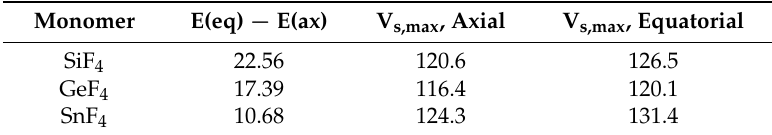
Table 3. Difference in energy (kcal/mol) between axial and equatorial vacancy on an idealized trigonal bipyramid structure of TF 4 molecule, along with maxima of molecular electrostatic potentials (kcal/mol) on the 0.001 a.u. isodensity